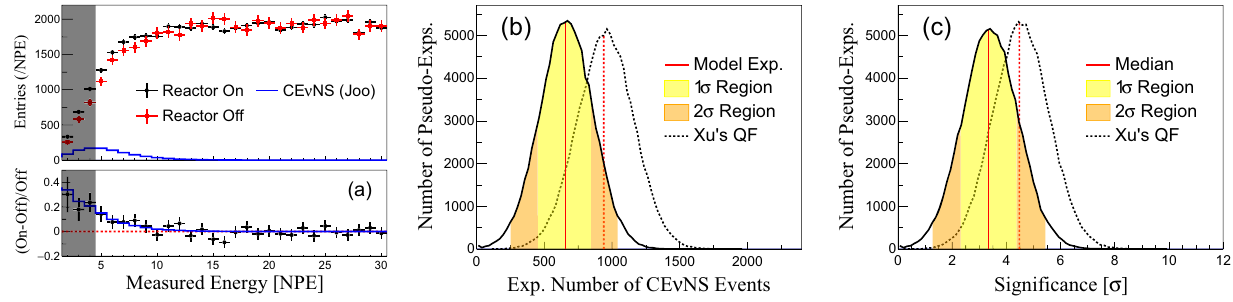
Fig. 26 a Example of the simulated experiments assuming 7 counts/day/kg/keV flat background, 22 PEs/keV light yield, 1- year reactor-on data (black points), and 100-days reactor-off data (red points) are presented. The reactor-off data is scaled with the ratio of time exposure between the reactor-on and reactor-off periods. The reactor-on data includes the expected CE ν NS events (blue line) obtained in Fig. 24 ( c ) for the QF values from Joo. In this pseudo experiment, the χ 2 fit obtains 649 ± 193 CE ν NS signal events. b Results of 100,000 independent simulated experiments are presented. Here a median expected number of signals, 650 events, was obtained